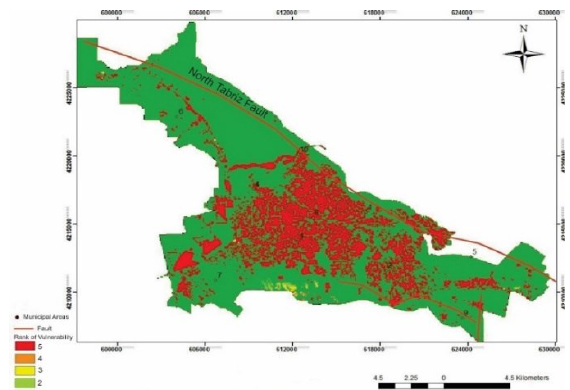
Fig. 13. Vulnerability map of area based on AHP weights